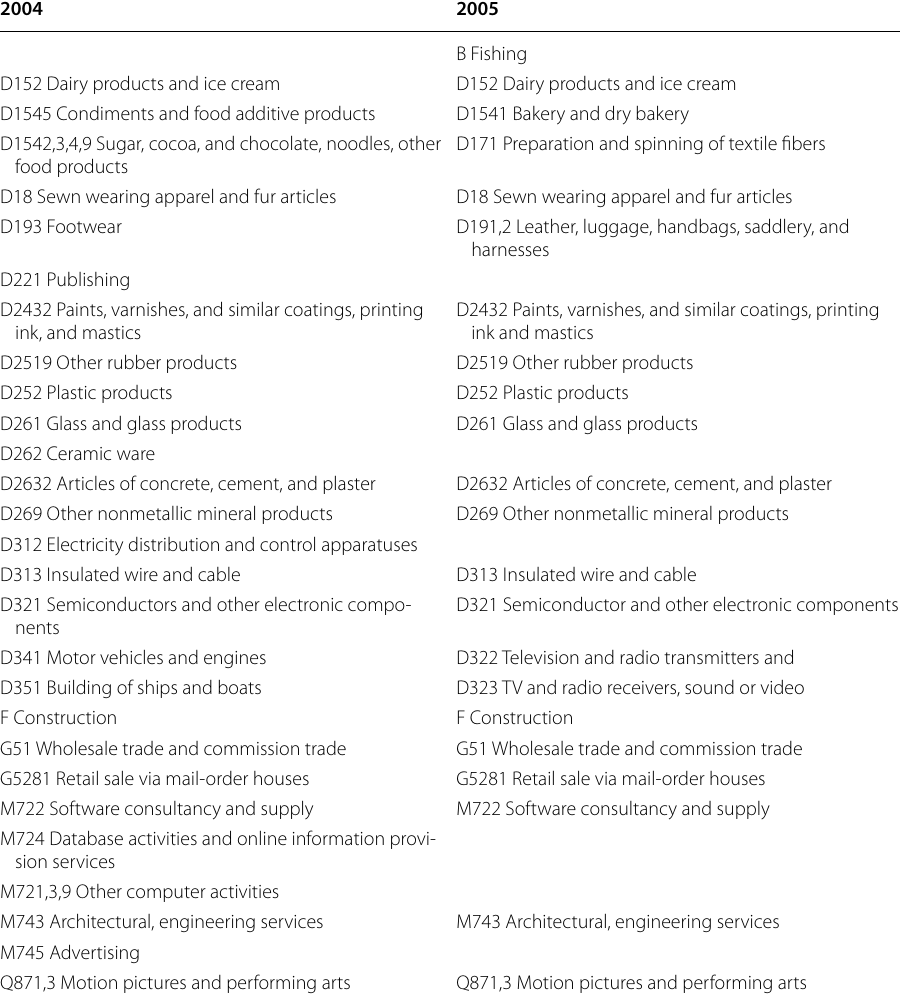
Table 11 Industries whose dispersion power indices are in the first quadrant 2004 2005